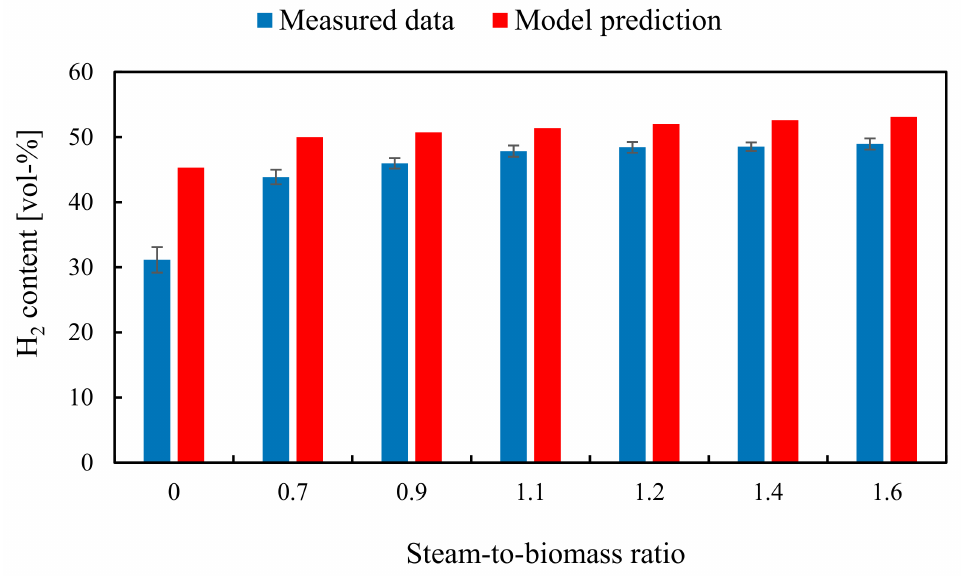
Figure 7. Effect of SBR on the hydrogen content.